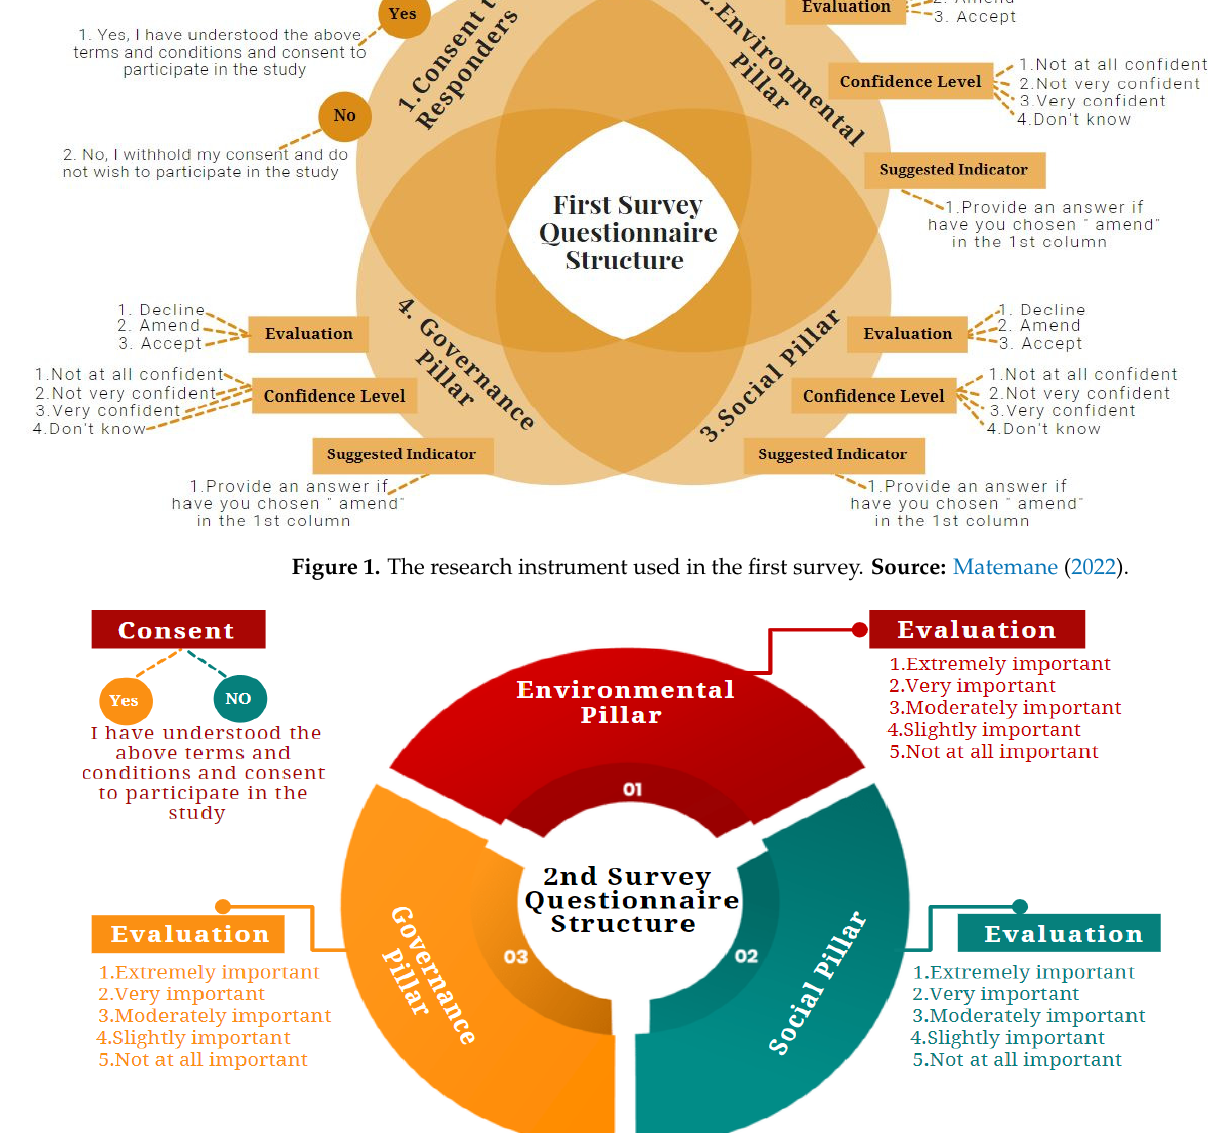
Figure 1. The research instrument used in the first survey. Source: Matemane (2022).